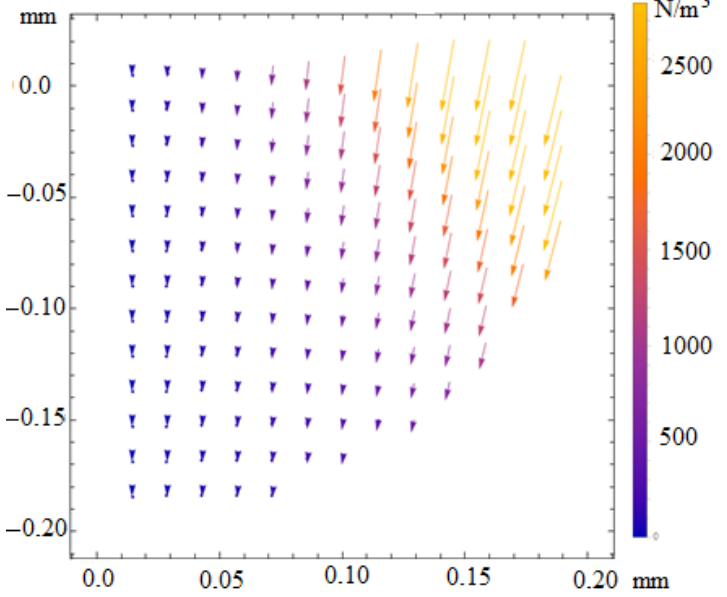
Figure 7. Vector distribution of the Lorentz force density in the molten pool formed by the laser beam. Only the right-hand side 𝑧 ≤ 0,𝑟 ≥ 0, √ r 2 + z 2 ≤ R b , θ = 0 of the computational domain is depicted in the cylindrical coordinates due to its rotational symmetry with respect to the Oz axis. The vector length is proportional to the modulus of the Lorentz force density [7].